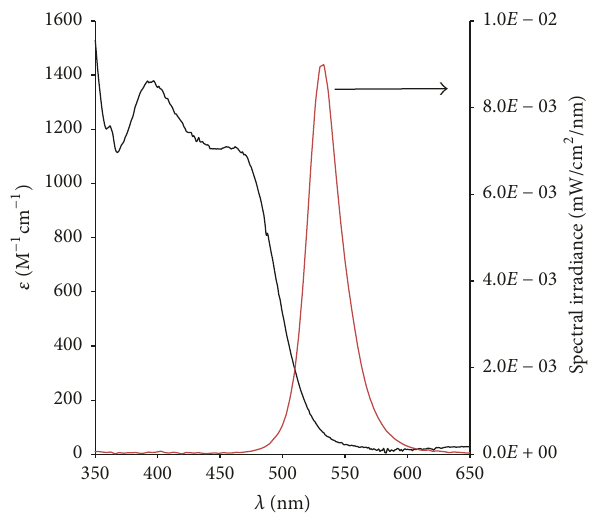
Figure 3: Ultraviolet-visible (Uv-vis) absorption spectrum of Irgacure 784 photoinitiator in toluene (left) and spectral irradiance distribution of the green LED light